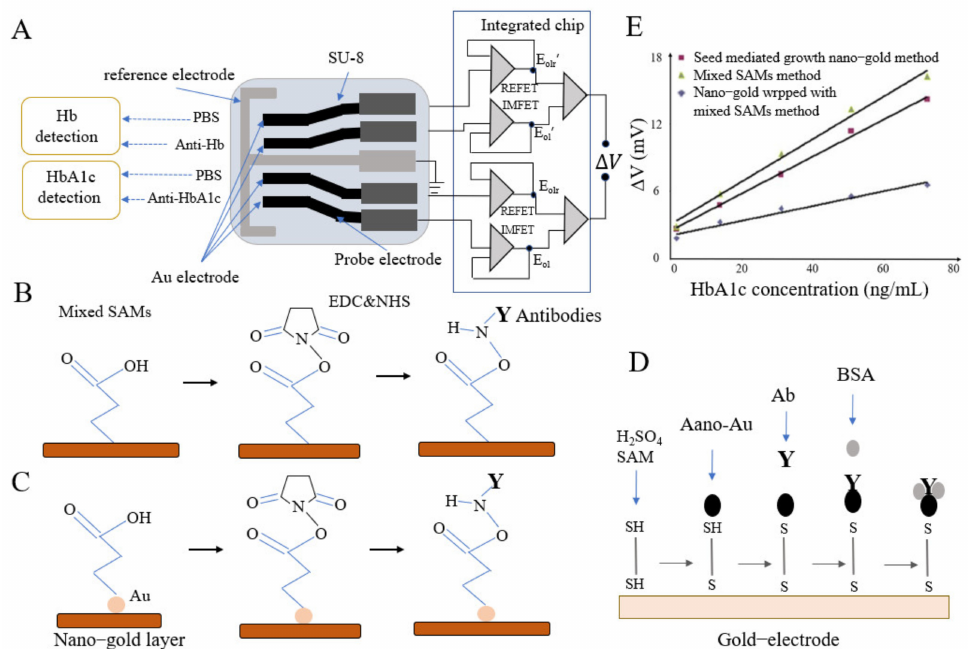
Figure 4. ( A ) Schematic diagram of HbA1c microsensor; ( B ) Mixed SAMs method; ( C ) Seed mediated growth nano-gold method; ( D ) HbA1c test strip prepared by SAM and nanotechnology; ( E ) Volt- age responses of three kinds of immunosensor in the simulated blood sample to HbA1c (reprint permission of A~E has been requested from